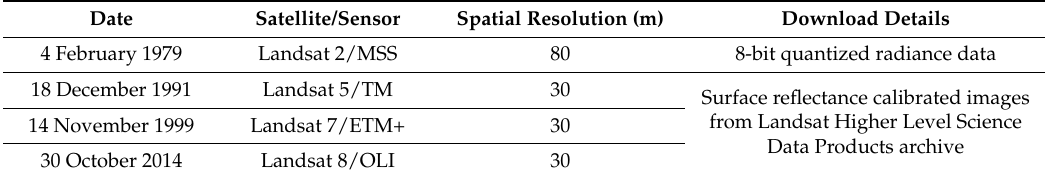
Table 1. Image data used to map land use in the Chambo